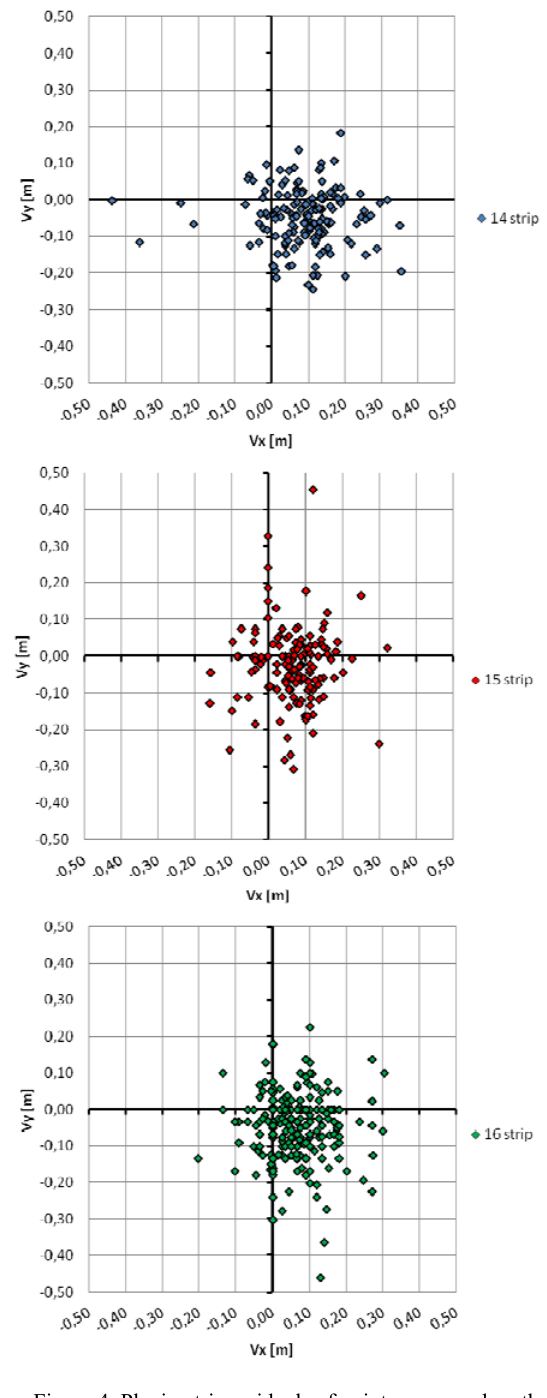
Figure 4. Planimetric residuals of points measured on the intensity raster in respect to their location on true-ortho for 3 analyzed scanning